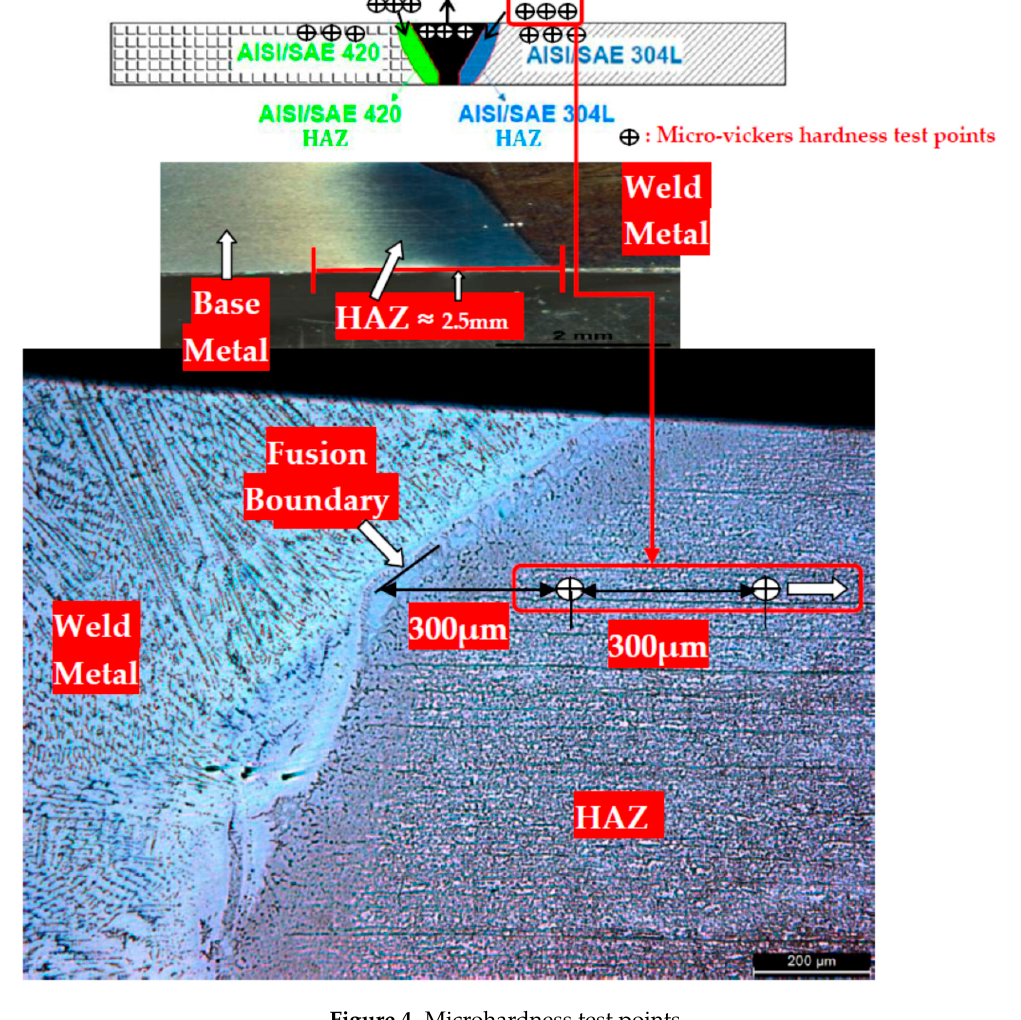
Figure 4. Microhardness test points